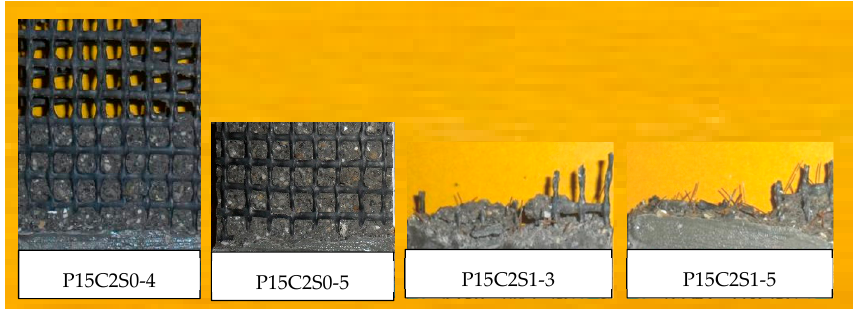
Figure 22. Fracture morphology of prestressed TRM specimens with two ‐ layer textiles.